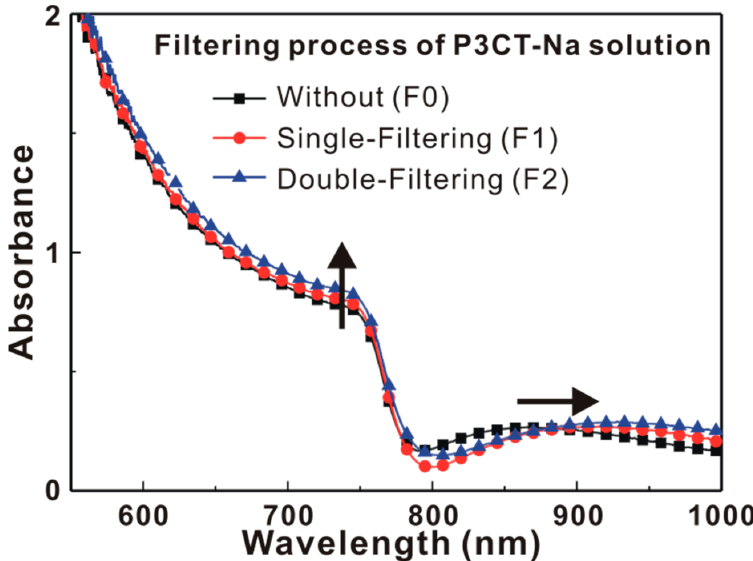
Figure 7. Absorbance spectra of the MAPbI 3 /P3CT-Na/ITO/glass samples.